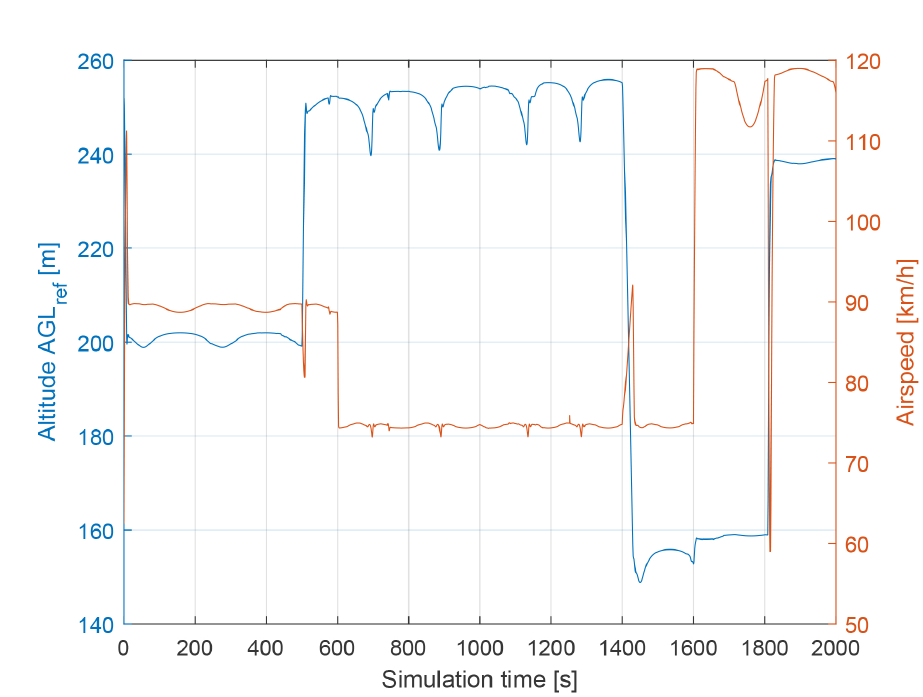
Figure 7. The altitude above ground level with respect to the reference point and airspeed as a function of simulation time.